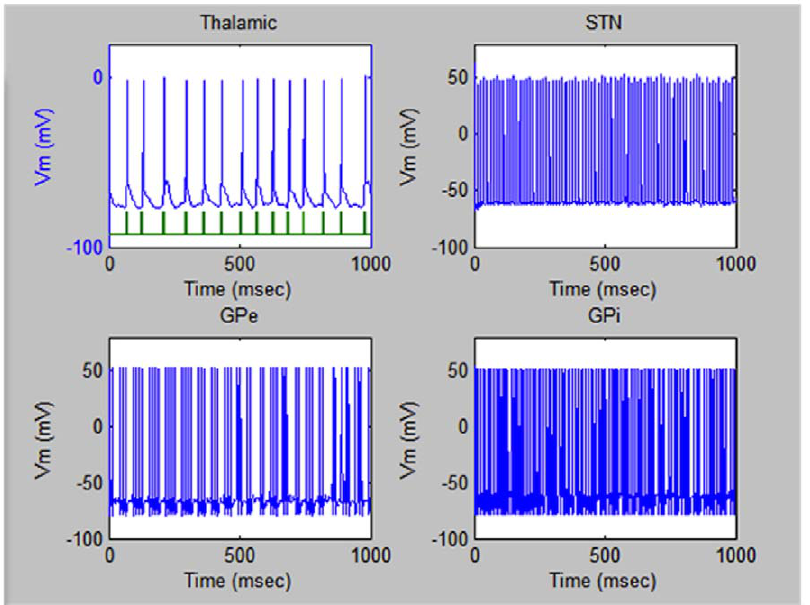
Figure 4. Electric pulses of a Parkinson’s patient after the non-invasive ME-nanoparticle treatment. Electric pulsed sequences triggered in the four regions of the brain under study of a patient suffering from Parkinson’s Disease after the treatment with the ME nanoparticles at the